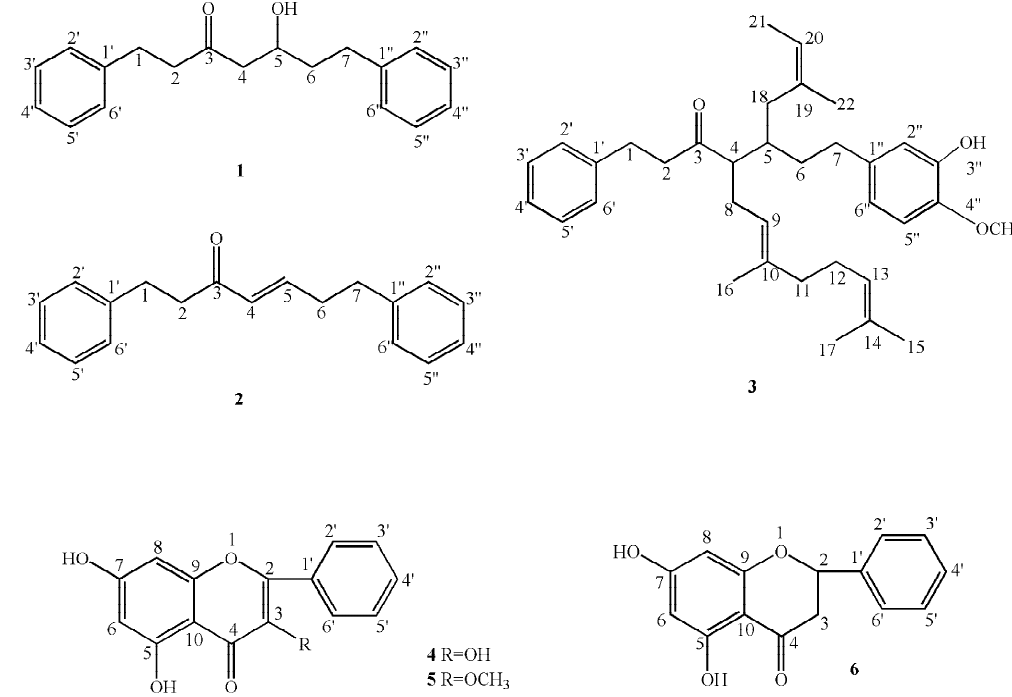
Figure 1. Compounds isolated from A. officinarum rhizomes extracted by supercritical fluid CO 2 extraction (SFE).